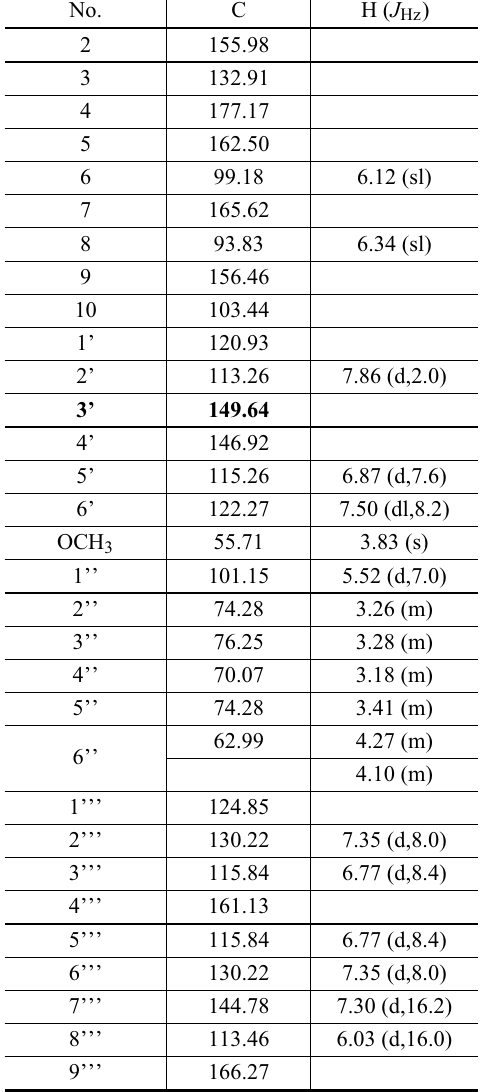
The 1 H and 13 C-NMR data of compound 4 (DMSO- d 6 ).